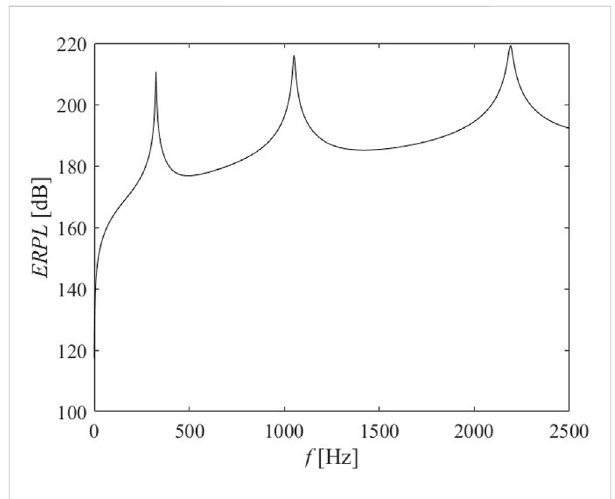
FIGURE 6 ERPL response of the beam when the shunt circuit is